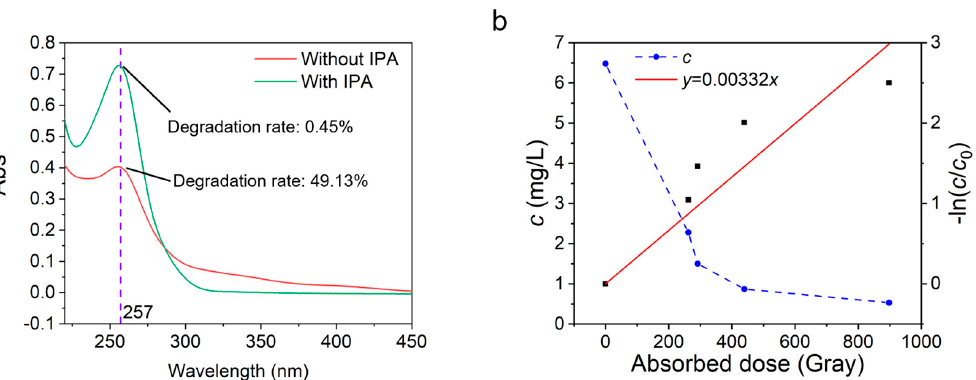
Figure 3. Validation tests of degradation kinetics model. ( a ) UV-visible spectrogram with or without IPA irradiation (initial SMZ = 9.72 mg/L, energy = 80 keV, beam current = 1 mA and pH = 12, absorbed dose = 76 Gray). ( b ) X-ray degradation of norfloxacin (initial NOR = 6.48 mg/L, energy = 80 keV, beam current = 1 mA, pH = 3.5) .